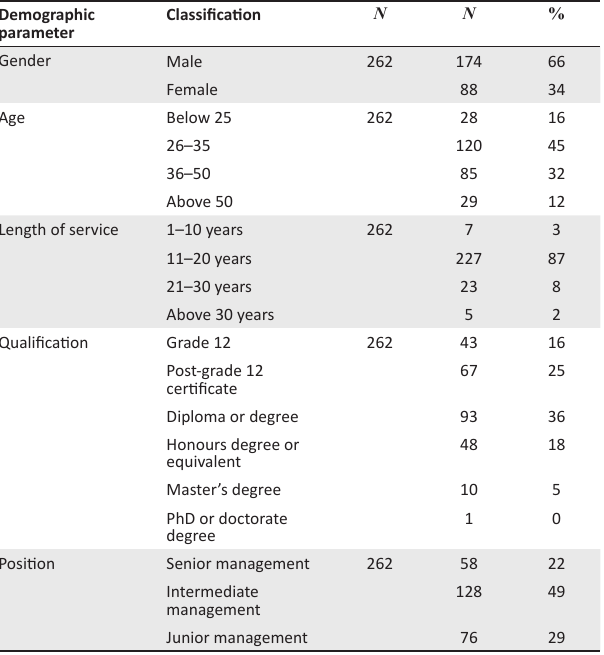
TABLE 2: Demographic profiling of respondents.